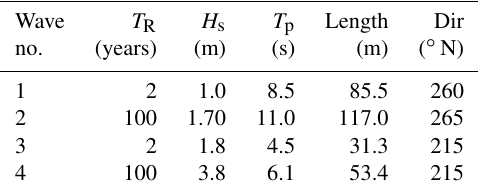
Figure 8. Wave field for the design wave condition generated by southern wind U = 22ms − 1 , Dir 215 ◦ N, T R = 2 years. (a) Entire domain, (b) harbour entrance. The blue bullet is the extraction point location; its UTM coordinates are 371221 ◦ E, 4478470 ◦ N. Table 4. Selected design wave states.